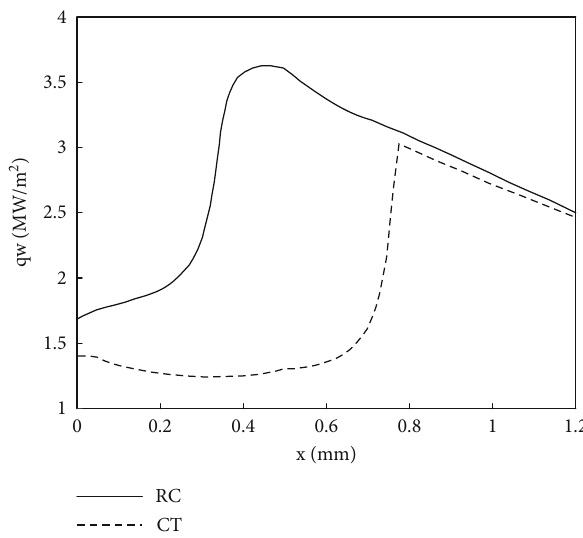
Figure 17: Distributions of wall heat fl ux along the cooling channel.